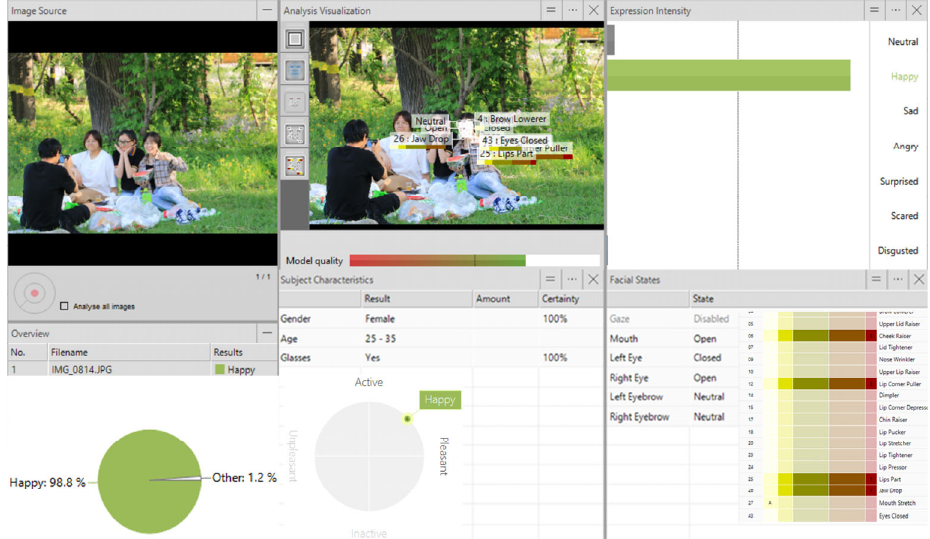
Figure 2. FaceReader 9.0 Facial